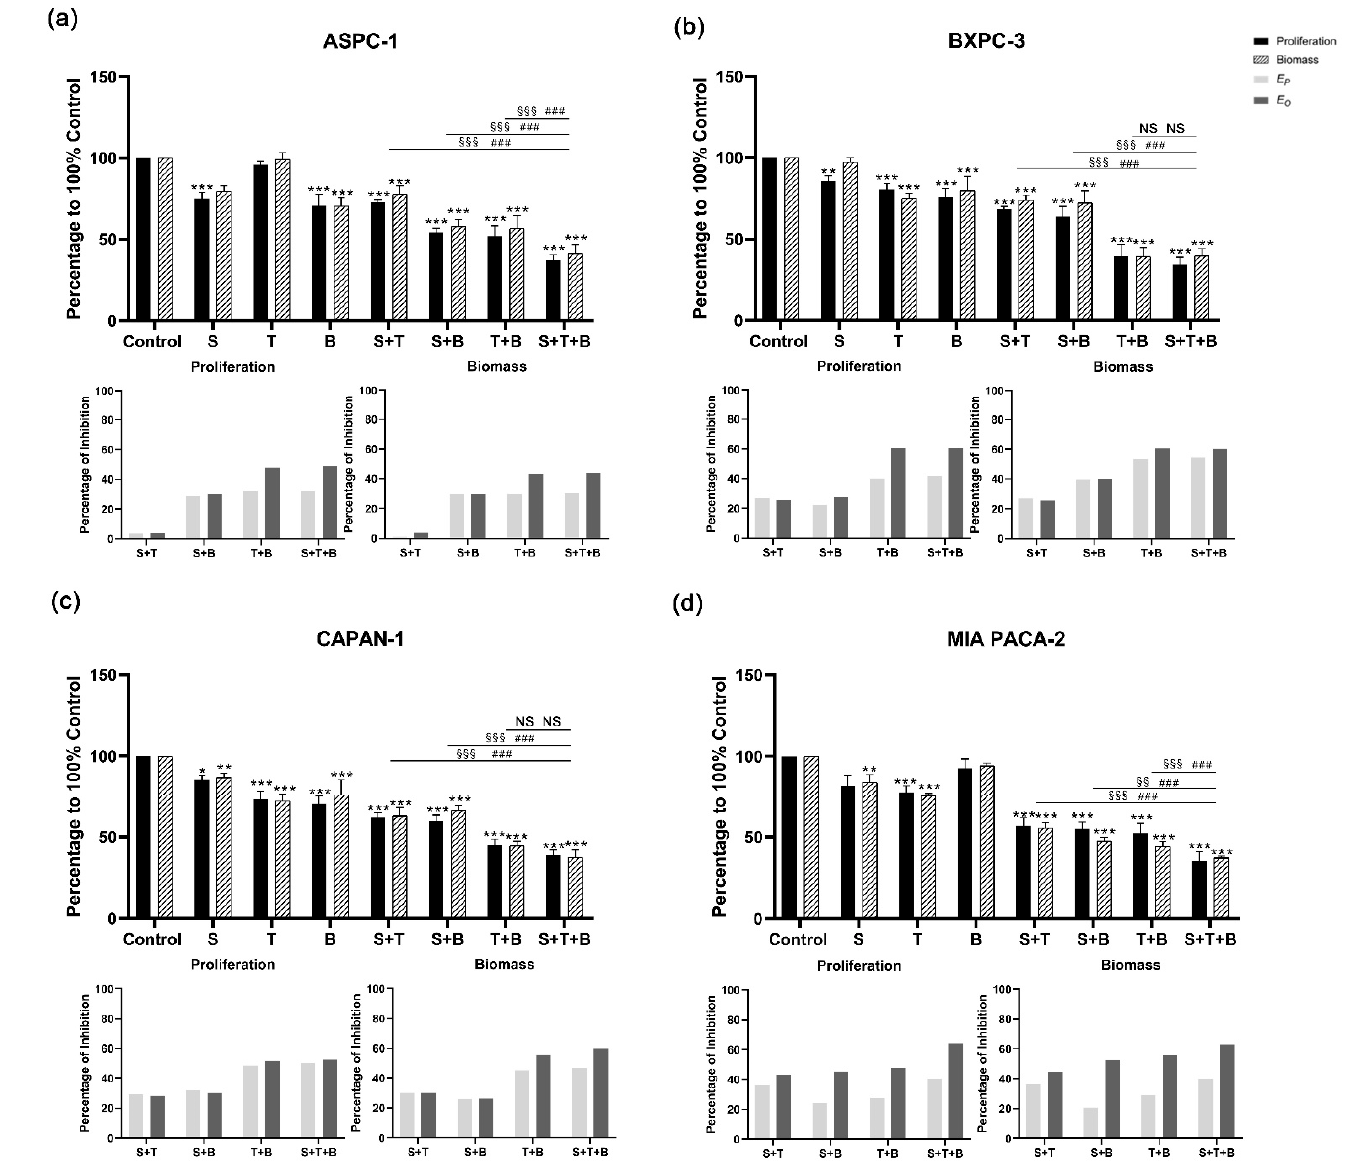
Figure 4. Cell proliferation and biomass of ASPC-1 ( a ), BXPC-3 ( b ), CAPAN-1 ( c ), and MIA PACA-2 ( d ) after 72 h sotorasib, trametinib, buparlisib or inhibitor combination exposure, as well as analysis of synergistic effect using Bliss independent model. Data are presented as mean ± SD. Significance of a treatment effect compared to the DMSO control was determined by one-way ANOVA and displayed as *: p < 0.033, **: p < 0.002, ***: p < 0.001 ( n ≥ 3). The significance of the treatment